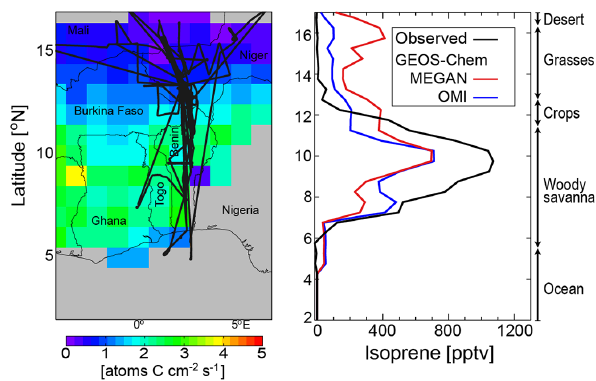
Figure 6. Latitudinal variability of isoprene in western Africa. Left panel shows the July–August 2006 AMMA flight tracks superim- posed on July–August 2005–2009 OMI-derived isoprene emissions (Marais et al., 2012). Right panel shows boundary-layer ( < 1km) isoprene concentrations along the AMMA flight tracks; observa- tions averaged over 0.5 ◦ latitude bands are compared to GEOS- Chem model results using either MEGAN or OMI-derived isoprene emission factors E o . Dominant MODIS IGBP biomes along the flight tracks are indicated.